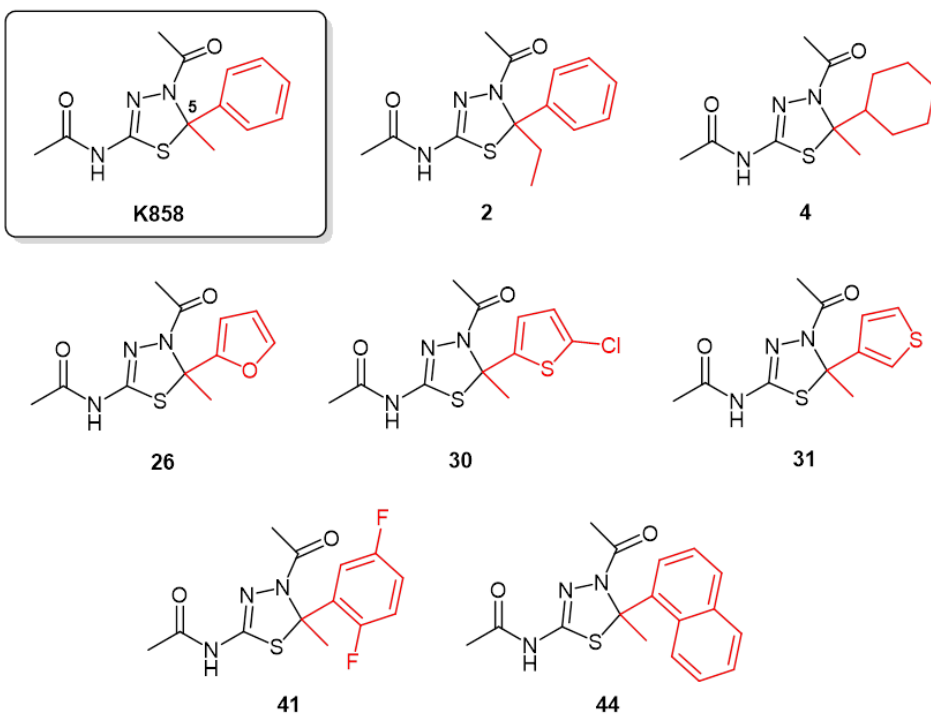
Figure 1. Molecular structures of selected thiadiazoline-based kinesin Eg5 inhibitors.